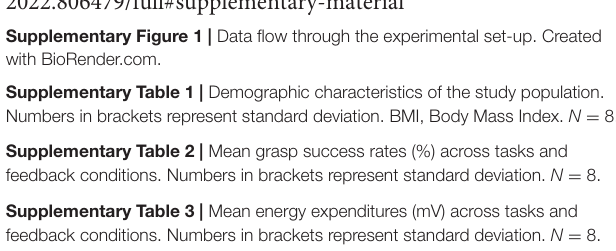
Supplementary Figure 1 | Data flow through the experimental set-up. Created with